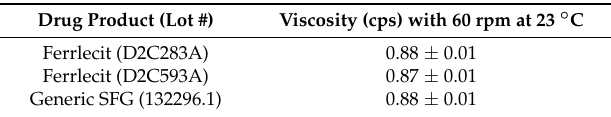
Table 3. Viscosity results of two Ferrlecit lots (D2C283A and D2C593A) and one generic SFG